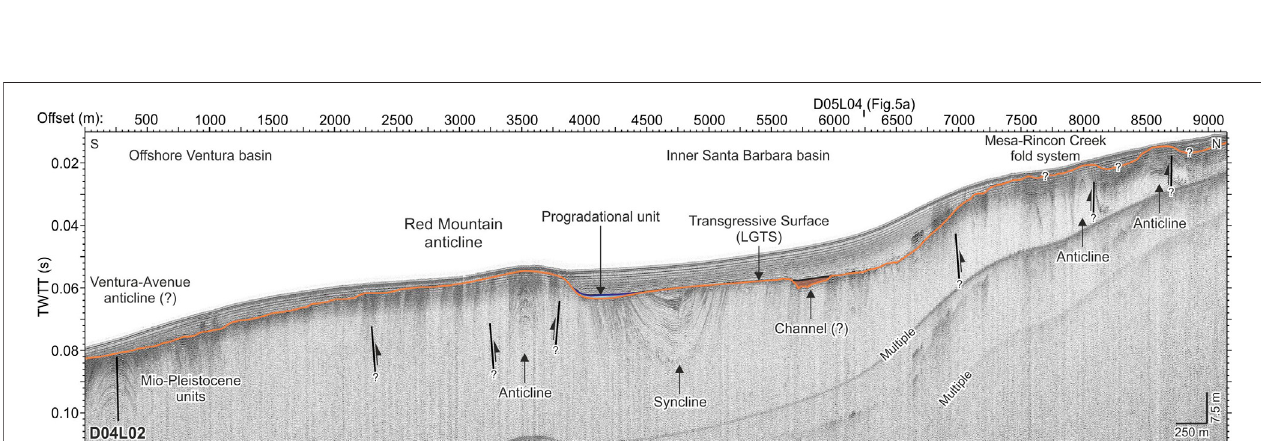
FIGURE 7 | Interpreted CHIRP strike pro fi le D04L02 showing the folding of the Last Glacial transgressive surface (LGTS; continuous orange line) related to the Mesa-RinconCreekfoldsystemandoffshoreRedMountain anticline.Thelightblueunitboundedbyadarkbluelinecorrespondstoaprogradationalunitandthebrown identi fi esapossiblechannel.Notethattheidenti fi edVentura-AvenueanticlineisclearlyfoldingthePleistoceneunitsbutnottheLGTS.Thelocationofthepro fi leisshown in Figures 2 , 3 . Uninterpreted pro fi le is provided in Supplementary Figure S7 .